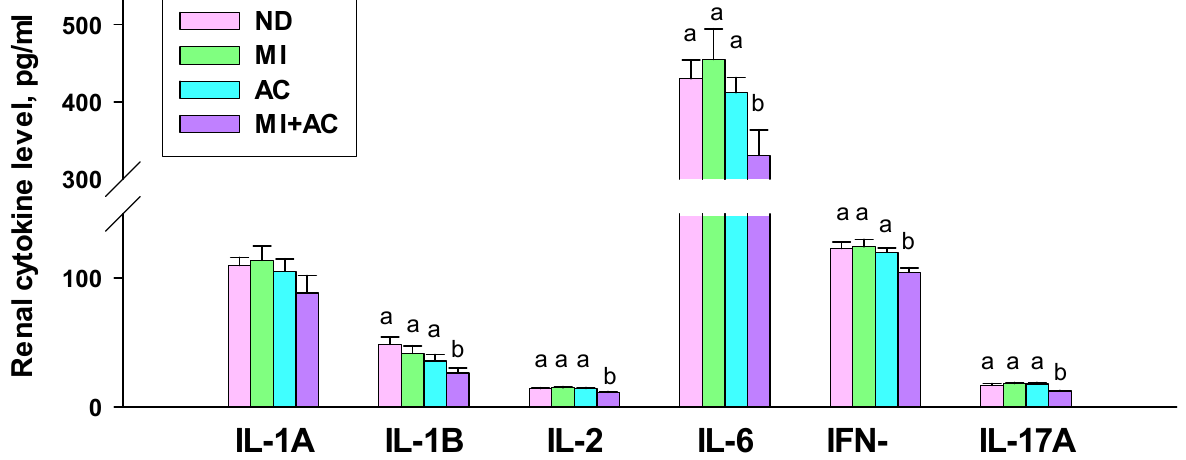
Figure 3. Effect of minocycline administration (MI) and acetate supplementation (AC) on cytokine levels in offspring at 12 weeks of age ( n = 7–8/group). The letters a and b above the bars denote significant differences between groups ( p < 0.05, one-way ANOVA). ND = rats received vehicle (control); MI = rats received minocycline; AC = rats received acetate; MI + AC = rats received minocycline and acetate